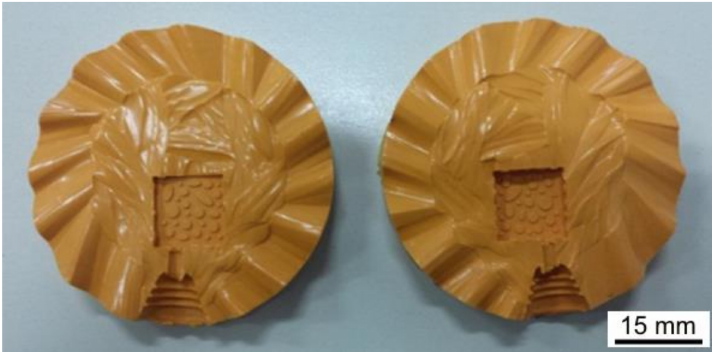
Figure 1. Silicone rubber mold for the metal